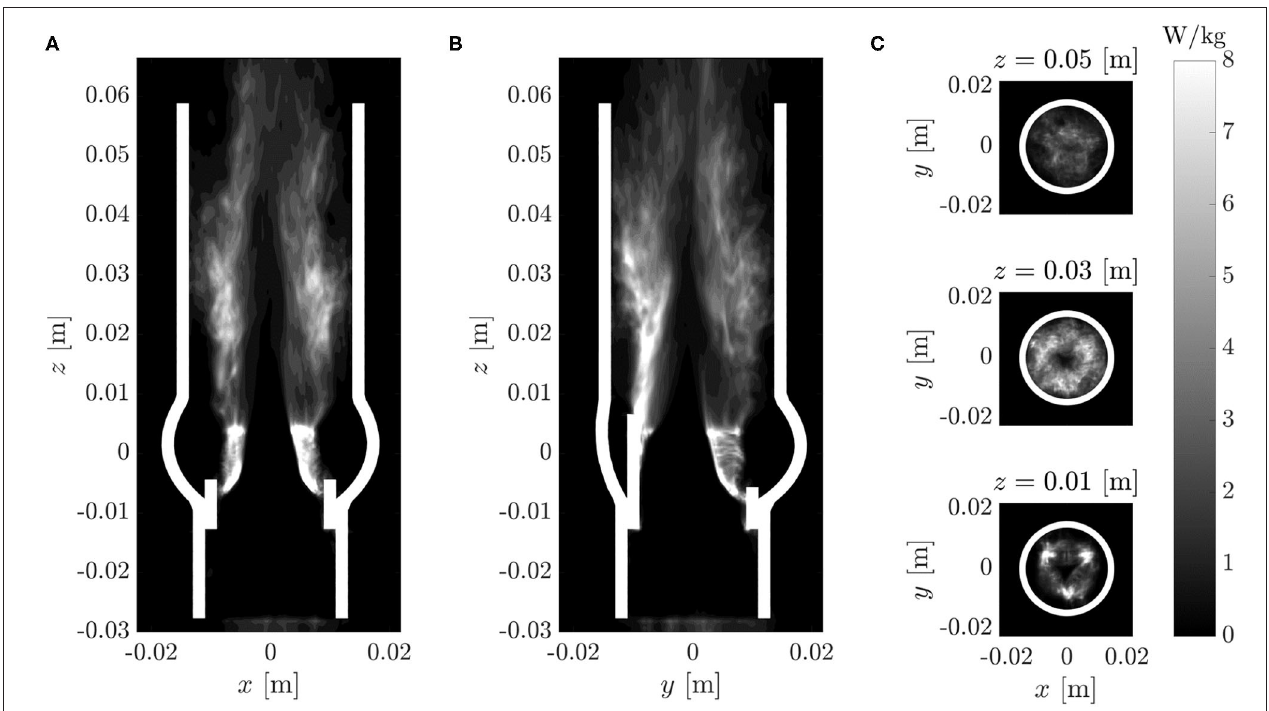
FIGURE 11 | Turbulent dissipation rate ǫ (same cross-sections as in Figure 7 ).